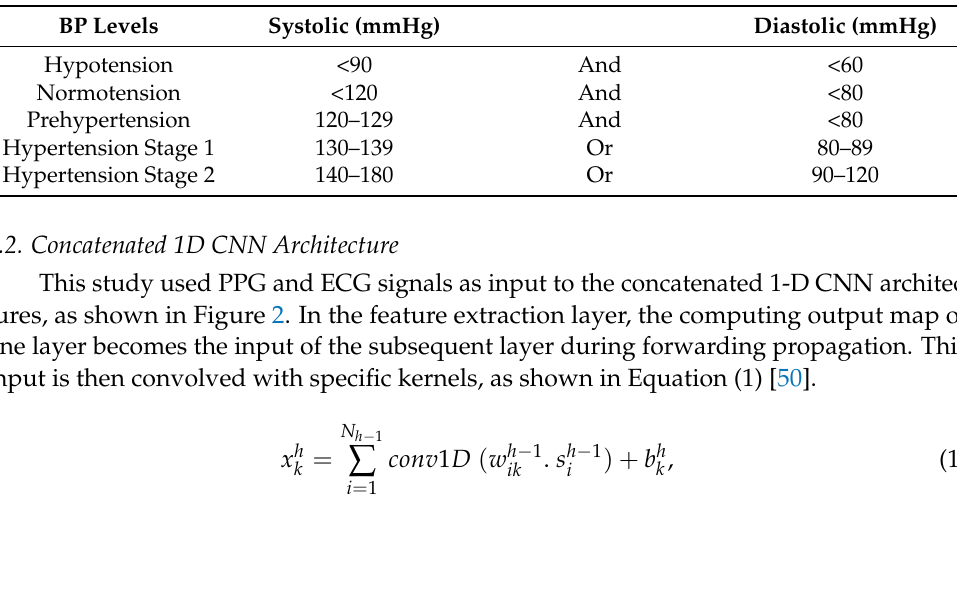
Table 1. The American Heart Association standard for blood pressure